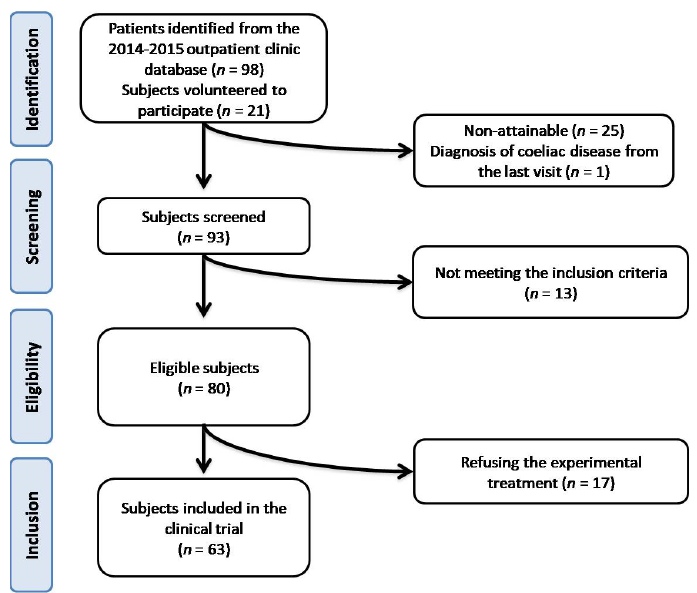
Figure 1. Flowchart resuming the selection criteria for the subjects enrolled in the trial.